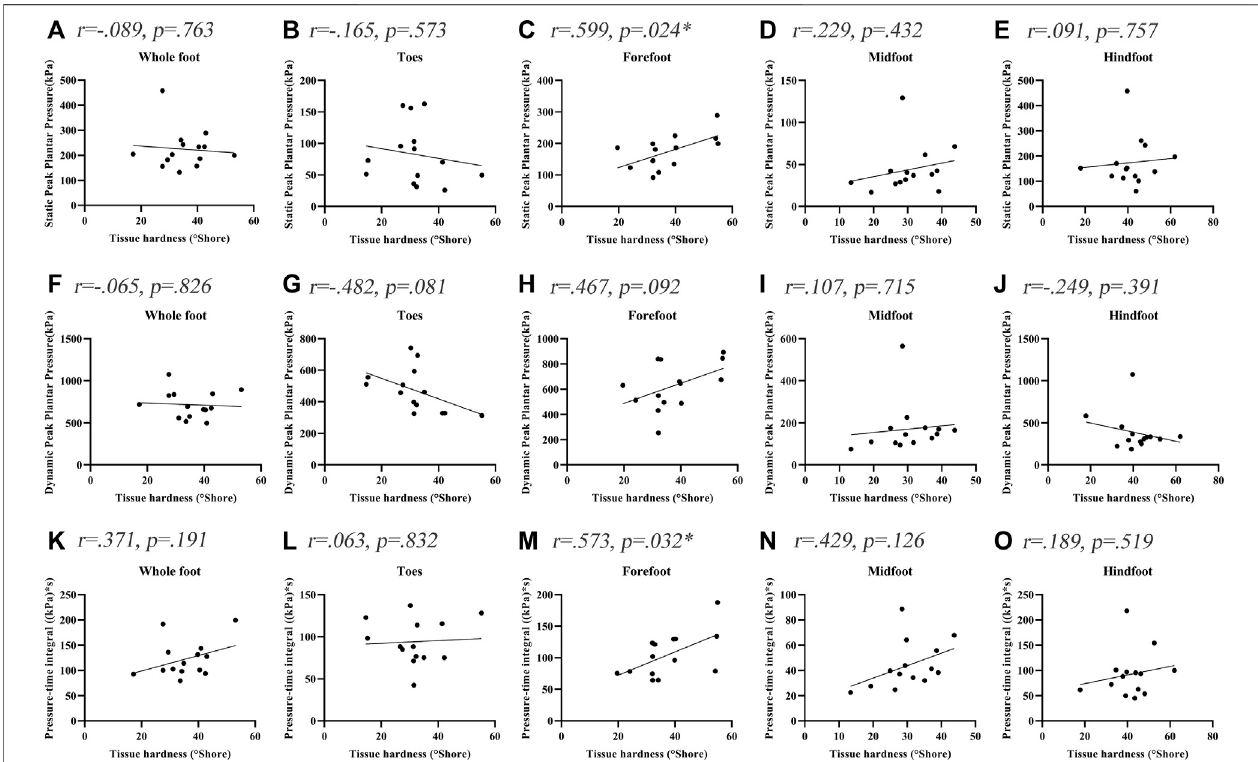
FIGURE 2 | Correlation coef fi cients between plantar tissue hardness and plantar pressure in people with DPN. * indicates a signi fi cant correlation ( p < 0.05). (A-E) representthecorrelation coef fi cientsbetweenplantar tissuehardnessandstaticpeakplantarpressureinthewholefoot,toesregion,forefootregion,midfootregionand hindfoot region, respectively. (F-J) represent the correlation coef fi cients between plantar tissue hardness and dynamic peak plantar pressure in the whole foot, toes region,forefootregion,midfootregionandhindfootregion,respectively. (K-O) representthecorrelationcoef fi cientsbetweenplantartissuehardnessandpressure- time integral in the whole foot, toes region, forefoot region, midfoot region and hindfoot region, respectively.